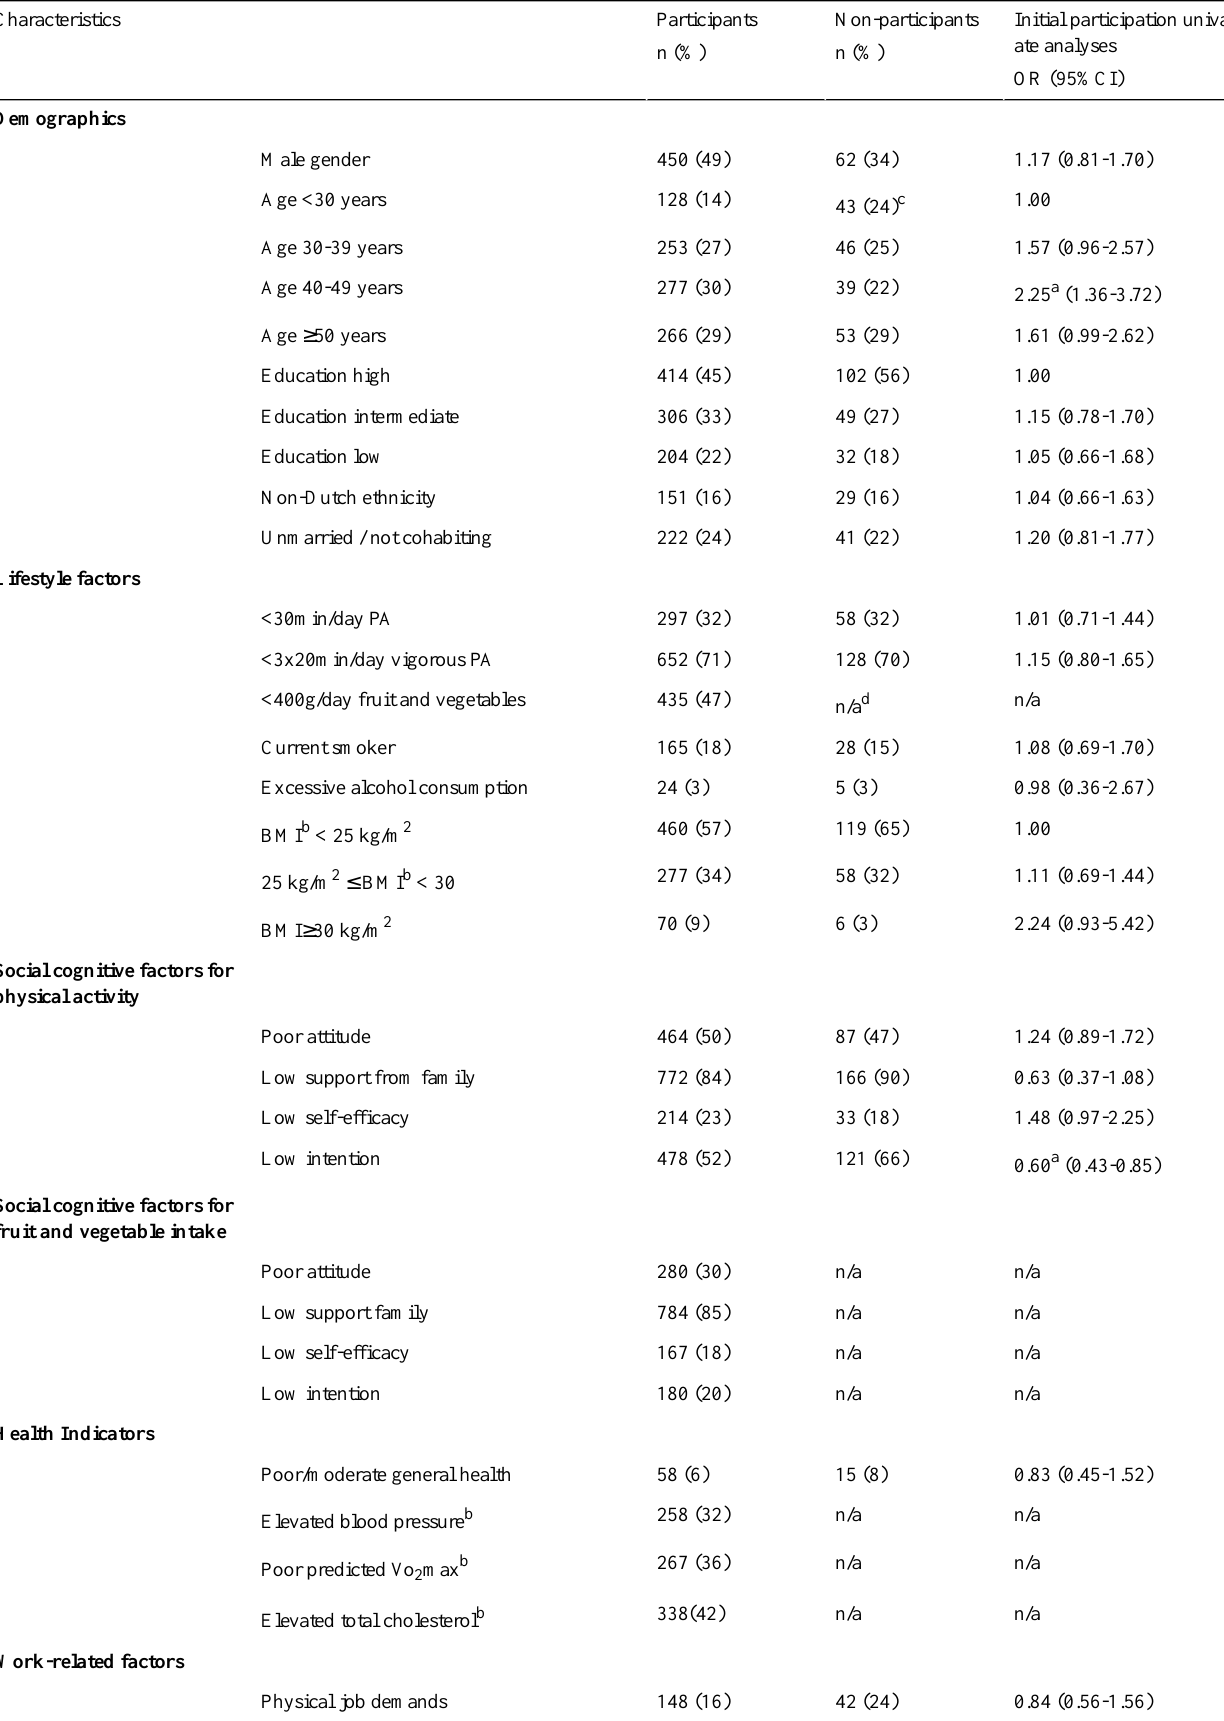
Table 1. Differences between participants (n=924) and a sample of non-participants (n=183) in a workplace health promotion program.